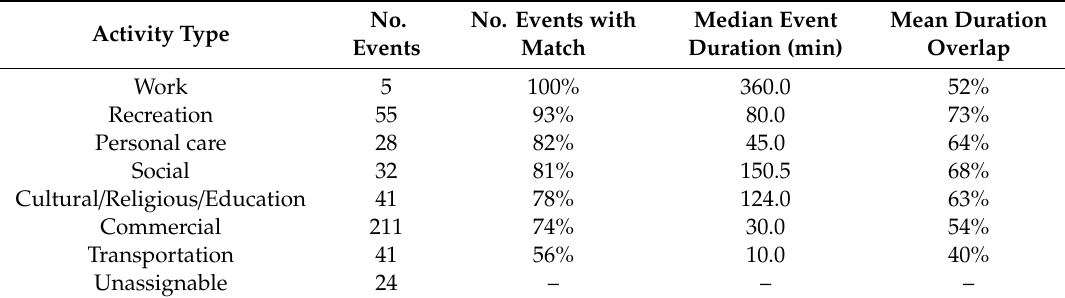
Table 8. Proportion of reported events that had a matching GPS event by reported event type (n = 437 events).